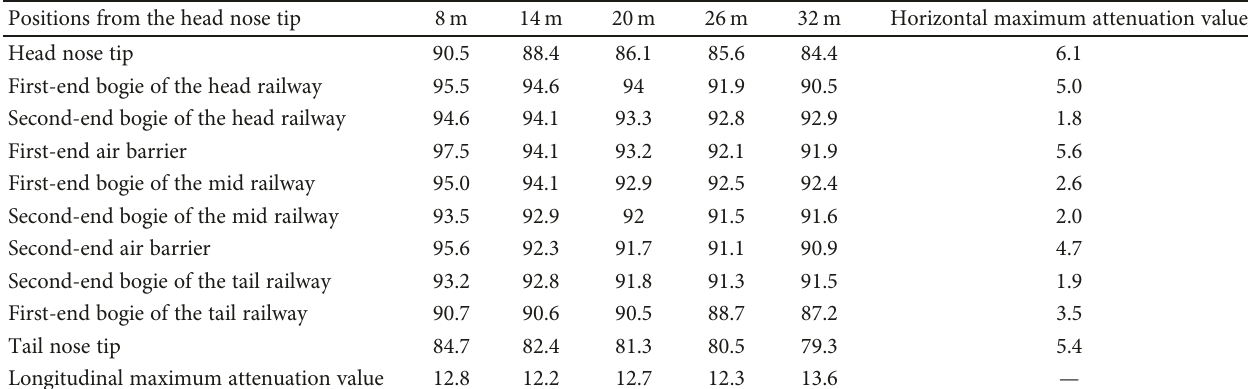
Table 1: Comparison table of sound pressure levels on horizontal monitoring points.